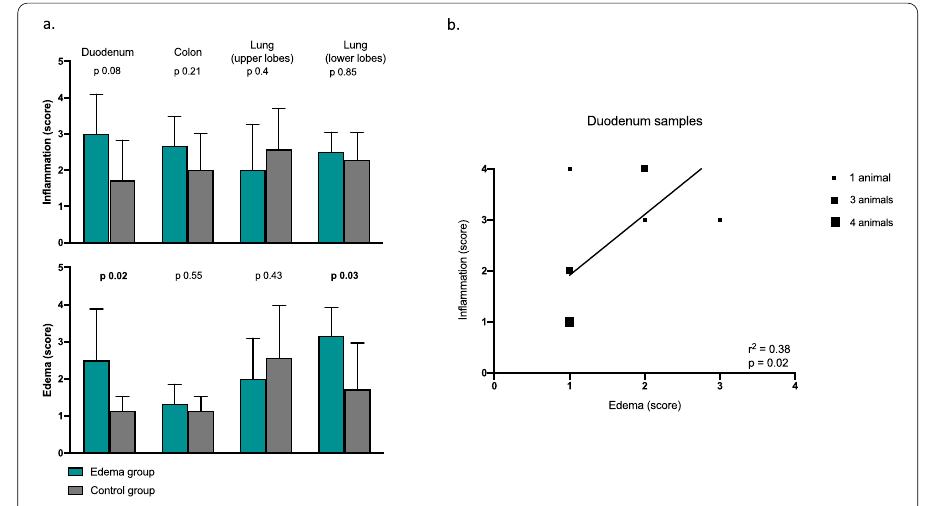
Fig. 4 a Acute inflammation and edema scores in duodenum, colon and lungs samples (from upper and lower lobes) compared using Mann–Whitney test. p values are reported for every comparison. b Correlation (Spearman’s coefficient) between inflammation and edema score in duodenum. The square dimension increases with the number of animals that had the same scores